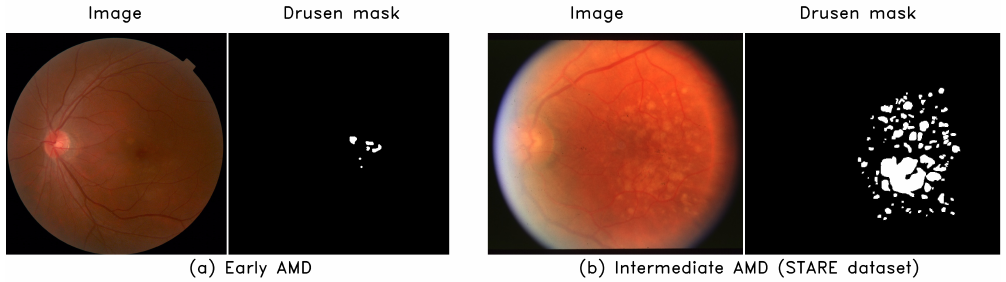
Figure 1. The comparison of drusen between early AMD and intermediate